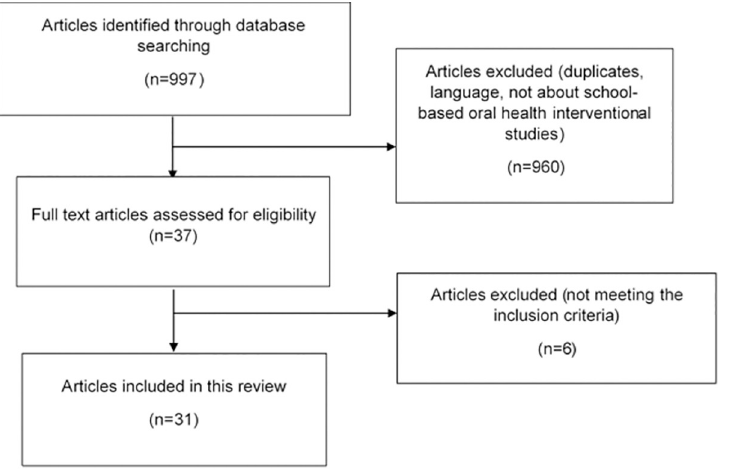
Fig 1. The flow diagram of the study selection